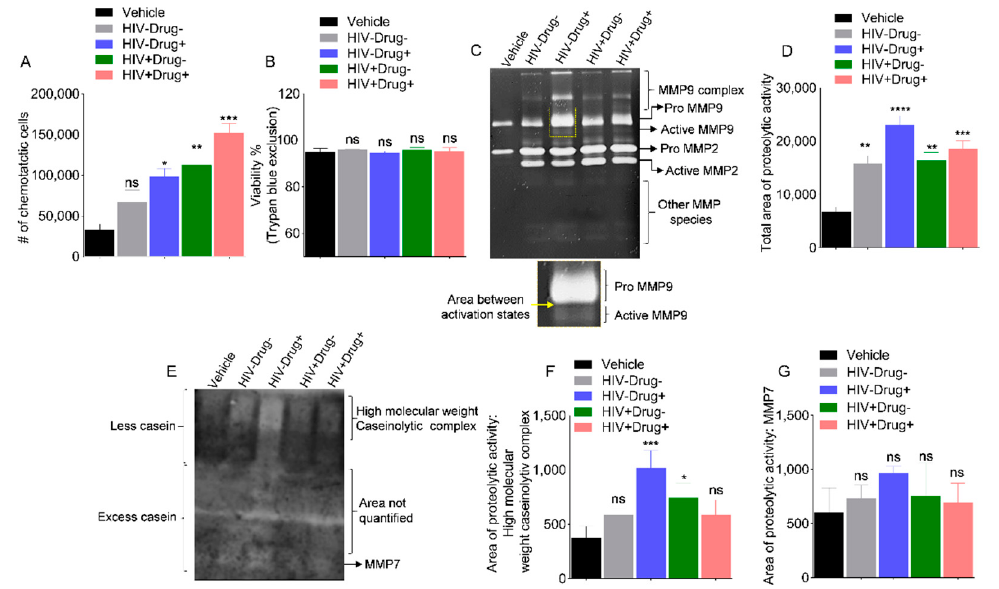
Figure 7. Monocyte chemotaxis and secretion of matrix-modifying enzymes are potentiated by SE from HIV-infected and HIV-uninfected participants with co-occurring psychostimulant use: 500,000 U937 cells were treated with vehicle PBS or 100 µ g / mL SE from the 4 clinical groups in serum-free media for 24 h before addition to the apical side of a chemotaxis chamber, containing 0% FBS (serum-free), 30% exosome-depleted FBS, or conditioned media from HIV-1 LAV-infected HeLa CD4 + cells (HIV secretome). The chambers were incubated for 20 h at 37 ◦ C in a 5% CO 2 incubator. The basal chamber cells were harvested and quantified by Trypan Blue hemocytometer counting. ( A ) Monocytes treated with the di ff erent SE were assessed for chemotaxis toward clarified supernatants collected from HIV-infected cells (HIV secretome), and the numbers of monocytes that migrated into HIV secretome in the basal compartment of the migration chamber are shown. ( B ) Viability of unmigrated cells in the apical chamber at the end of the experiment expressed as % of viable cells. ( C ) Representative (n = 3) gelatin Zymograph of conditioned media (secretome) from monocytes treated with the various SE prior to loading into migration chambers. The area within the square box is enlarged below to highlight active MMP9. ( D ) Image J quantification (total densitometry) of total gelatinolytic activity of each zymogram lane presented as the total area of proteolytic activity. Data represent the mean of triplicate experiments, and error bars are standard error of the mean. ( E ) Representative (n = 3) β -casein zymography of the same conditioned media used in gelatin zymography. Image J quantification (densitometry measurement) of Figure 7F’s ( F ) high molecular weight caseinolytic complex and ( G ) MMP7 activities of each zymogram lane presented as area of proteolytic activity. Experiments were repeated three times with similar trends. Ordinary one-way ANOVA (Dunnett’s correction) test was used to determine the significance of di ff erent SE treatments relative to vehicle. * p < 0.05, ** p < 0.01, *** p < 0.005, **** p < 0.001, and ns,